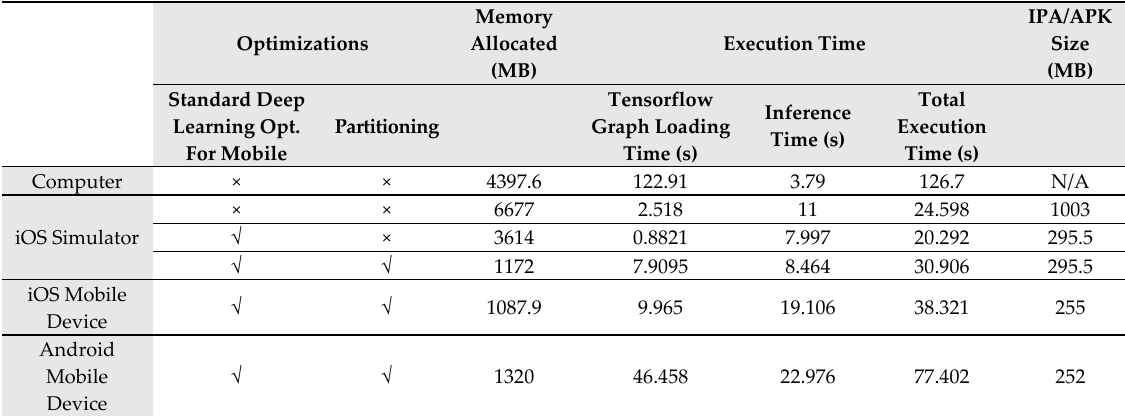
Table 1. Results when Running our Deep Neural Network under Different